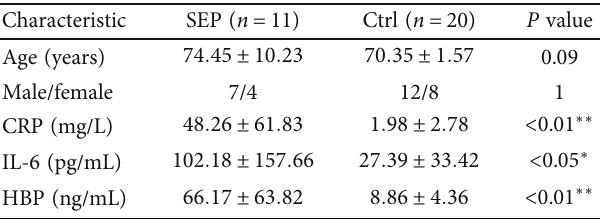
Table 1: Demographic and clinical characteristics of the two